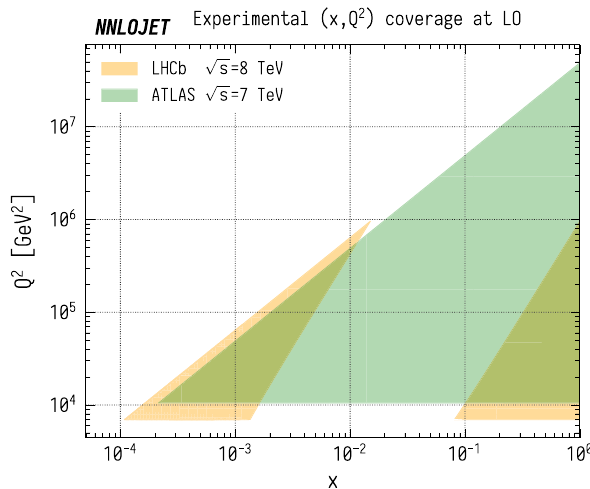
Fig. 1 The regions of the ( x , Q 2 ) plane accessible for the LHCb [16] and ATLAS [8] ZJ selection criteria at LO. Here Q 2 is the invariant mass of the full final state including both charged leptons and QCD radiation and x is the Bjorken-x from either of the incoming beams